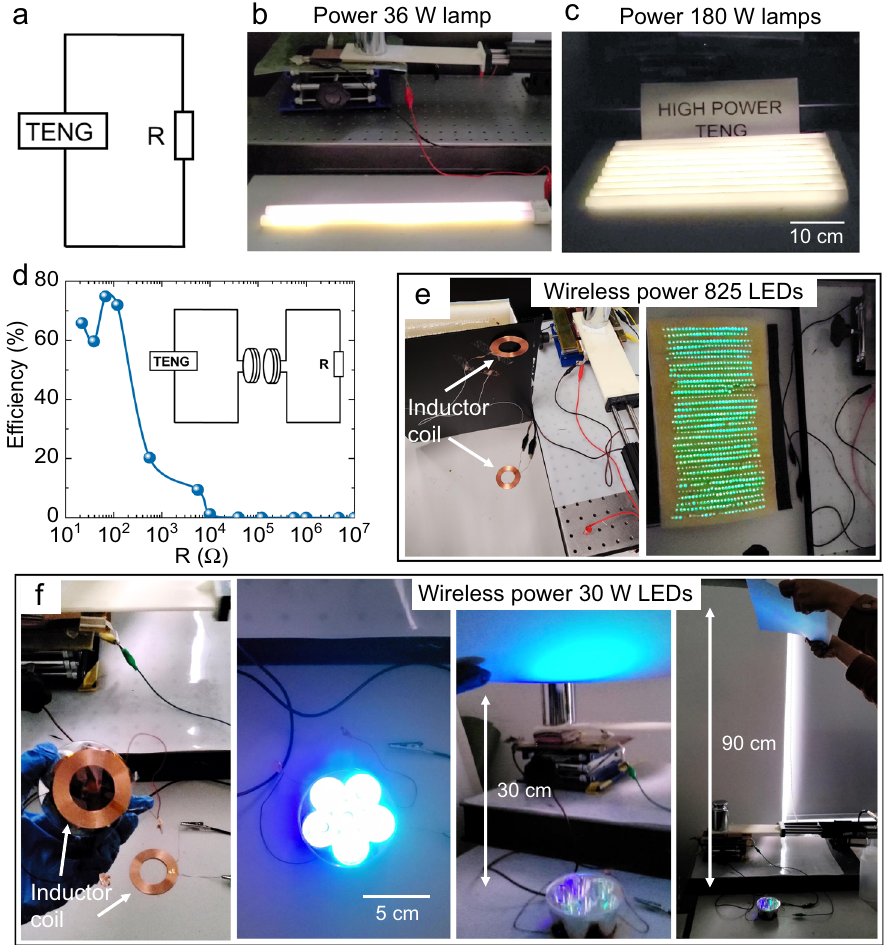
Fig. 5 Demonstration of powering electrical devices by OCT-TENG. a Circuit of directly powering the load devices using OCT-TENG. b A 36 W lamp and c 180 W lamps powered by the OCT-TENG. d wireless power transmission ef fi ciency depending on the load resistance. Inset is the circuit of the wireless powering the load devices. e 825 LEDs being wirelessly powered by the OCT-TENG. f Vehicle bulb with 30 W LEDs powered by the OCT-TENG and illuminating objects 0.9 meters